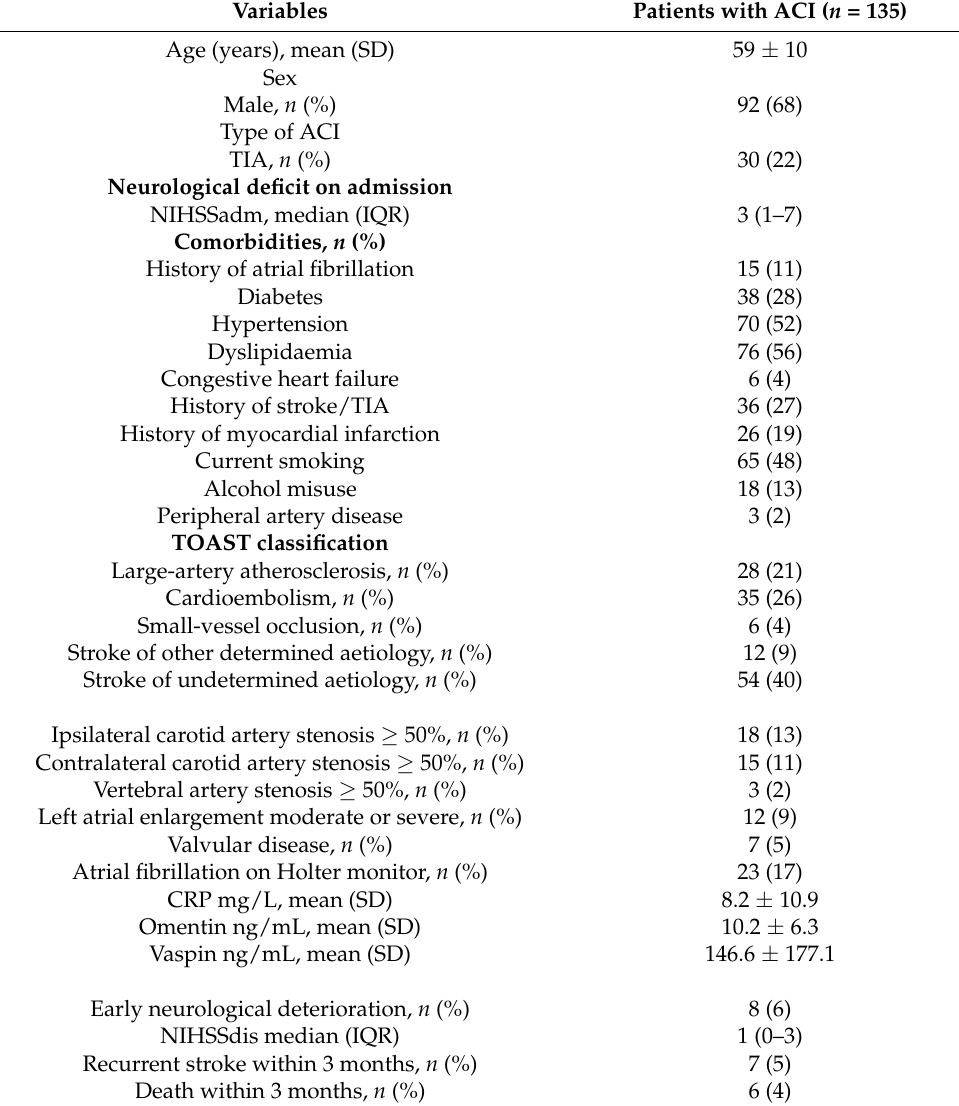
Table 1. Baseline characteristics, neuroimaging findings, ischemic stroke classification and clinical outcomes of ACI